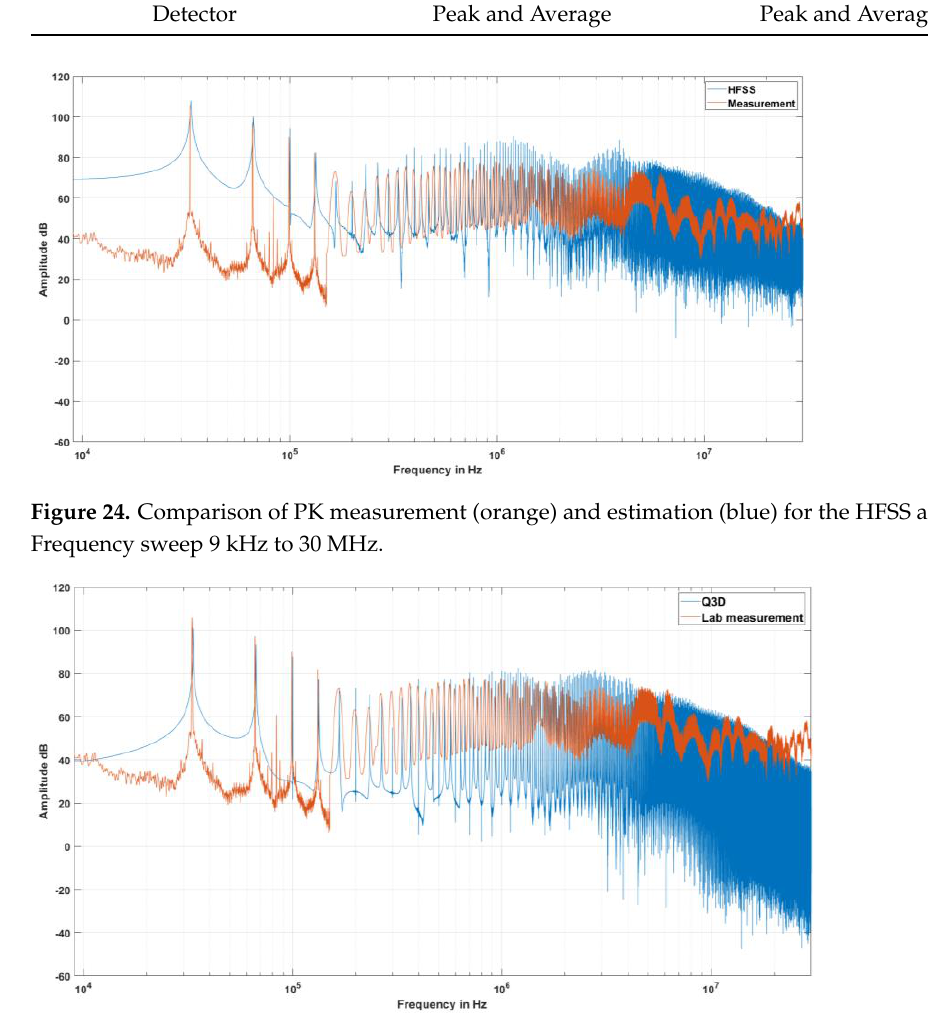
Figure 25. Comparison of PK measurement (orange) and estimation (blue) for Q3D approach. Frequency sweep 9 kHz to 30 MHz.